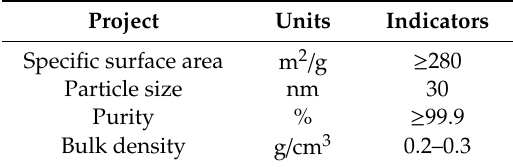
Table 1. Basic properties of anatase nano TiO 2 .